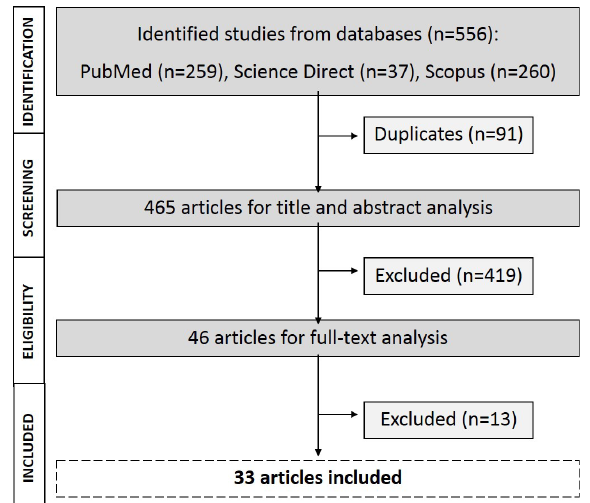
Figure 3. Flowchart of literature review process for biological and pharmacological activity of Valeriana